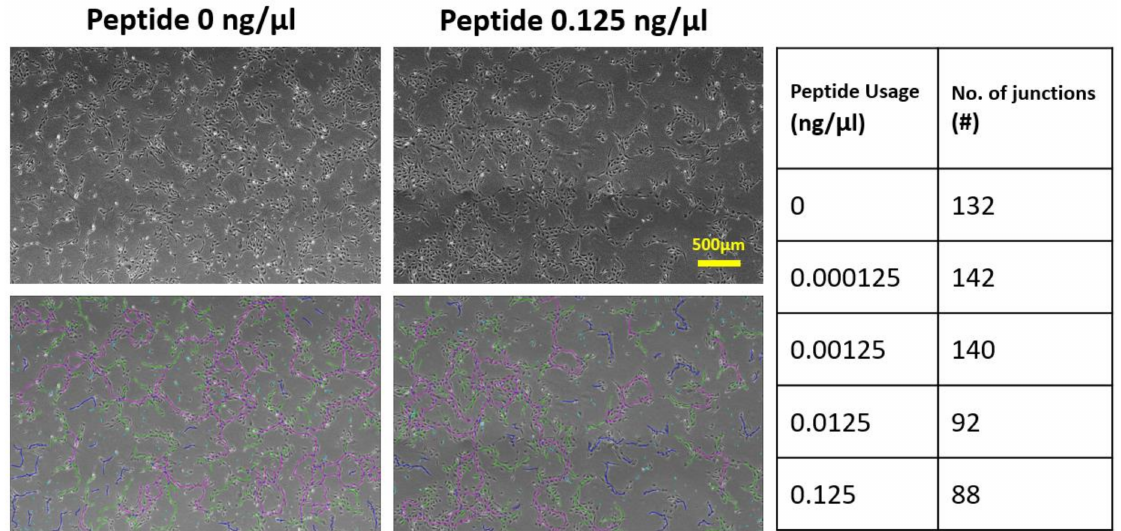
Figure 4. The effect of VBP dosage on the cell network integrity. The average number of network junctions per view field served as a quantitative indicator of network integrity. Cell cords recognized by ImageJ software are shown, where the pink lines present the segments (connections between two junctions), the green lines the branches (connections between junction and node), and the blue lines the isolated elements (connections between two nodes). Data were collected after 24 h of cell culture and averaged with three repeated